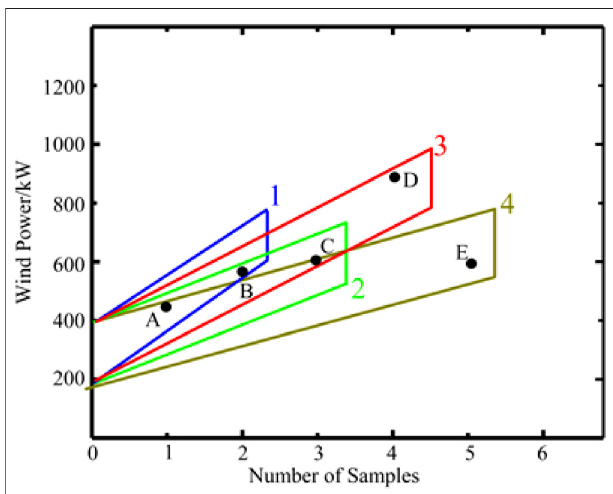
FIGURE 1 | The principle of spinning door algorithm.